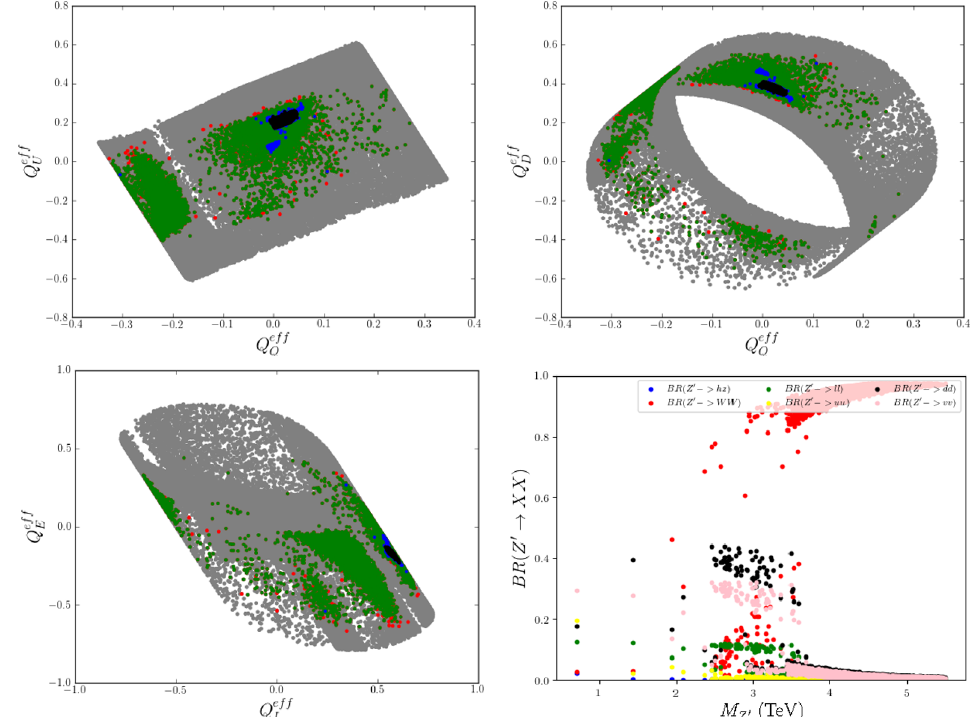
Figure 3 . The distributions of the e(cid:11)ective U(1) 0 charges for quarks and leptons over the following planes: ( Q e(cid:11) ; Q e(cid:11) ) (top left), ( Q e(cid:11) ; Q e(cid:11) ) (top right) and ( Q e(cid:11) ; Q e(cid:11) ) (bottom left). In the bottom Q U Q D L E right plot we show the BRs of the Z 0 for di(cid:11)erent decay channels, BR( Z 0 ! XX ) as a function on M Z 0 , where XX represents a SM two-body (cid:12)nal state. Our colour convention is as listed at the end of section 3 and the bottom right panel contains only the \Blue" points in the other panels. eq. (2.17), for left and right chiral fermions by visualising our scan points over the planes ( Q e(cid:11) ; Q e(cid:11) ), ( Q e(cid:11) ; Q e(cid:11) ) and ( Q e(cid:11) ; Q e(cid:11) ). As seen from the top left and right panels, when Q U Q D L E